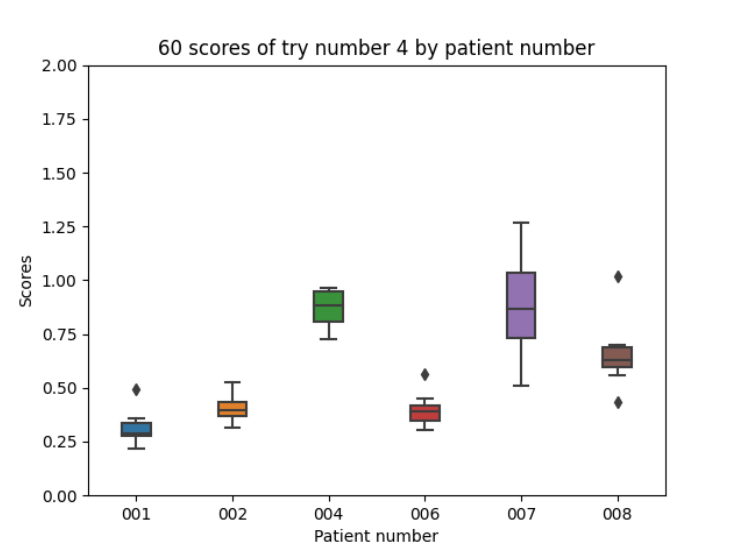
Figure 15. Experiment 4 boxplot scores, from 10 executions for each patient and